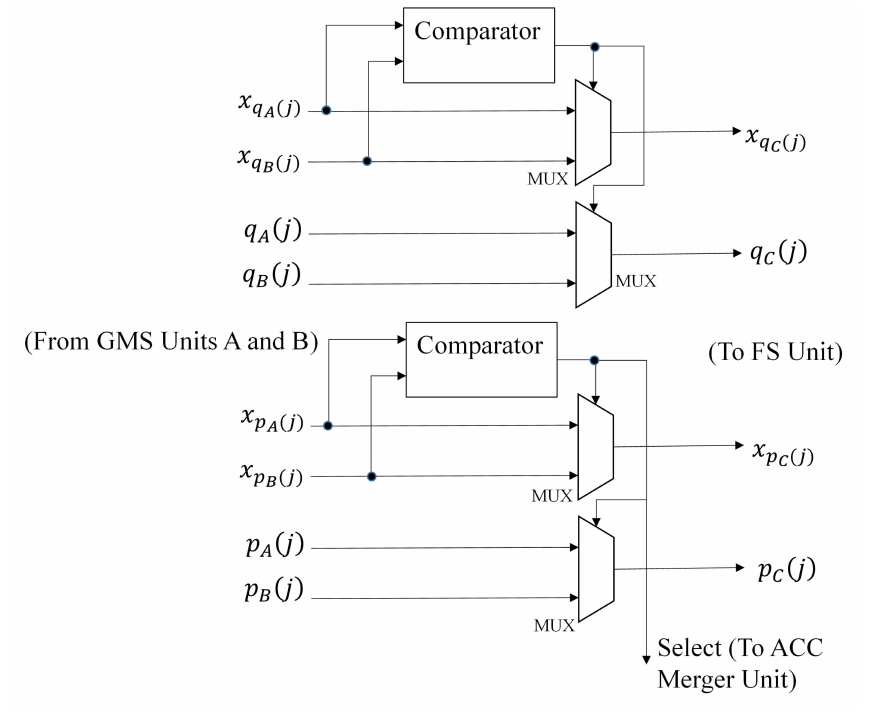
Figure 10. The architecture of the GMS merger unit.